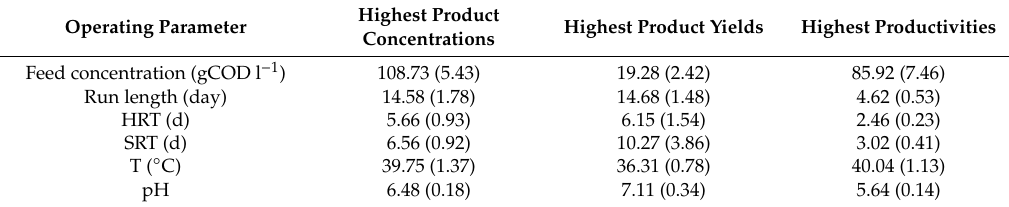
Table 5. Mean value and standard error (in brackets) of operating parameters for process performance parameters above the 90th